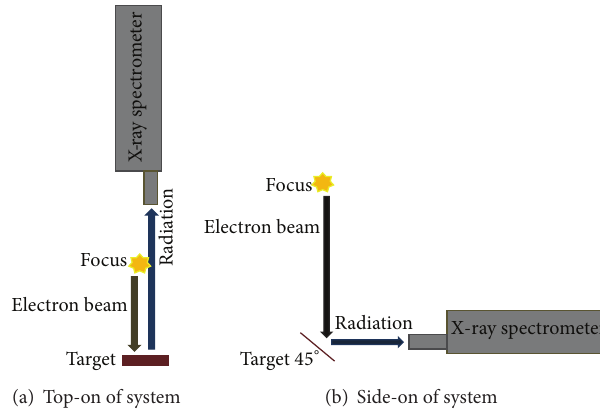
Figure 4: X-ray spectrometer position at top-on of system with target (a) and side-on of system with target at an angle of 45 degrees (b).